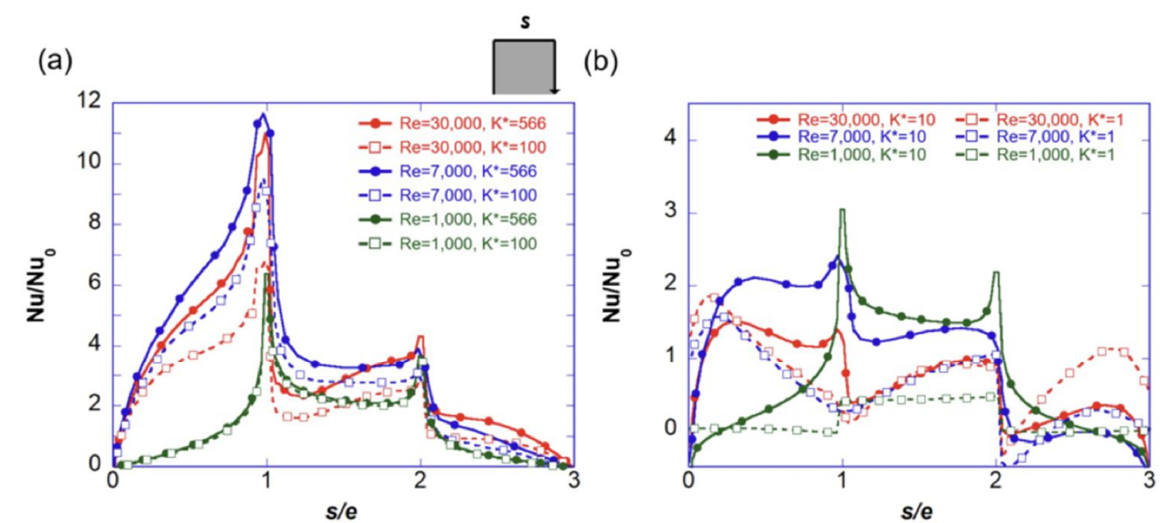
Figure 7. Effect of Reynolds number on the local convective heat transfer in the rib: ( a ) for high thermal conductivity ratios ( K * = 566.26 and 100.00) and ( b ) for low thermal conductivity ratios ( K * = 10.00 and 1.00).